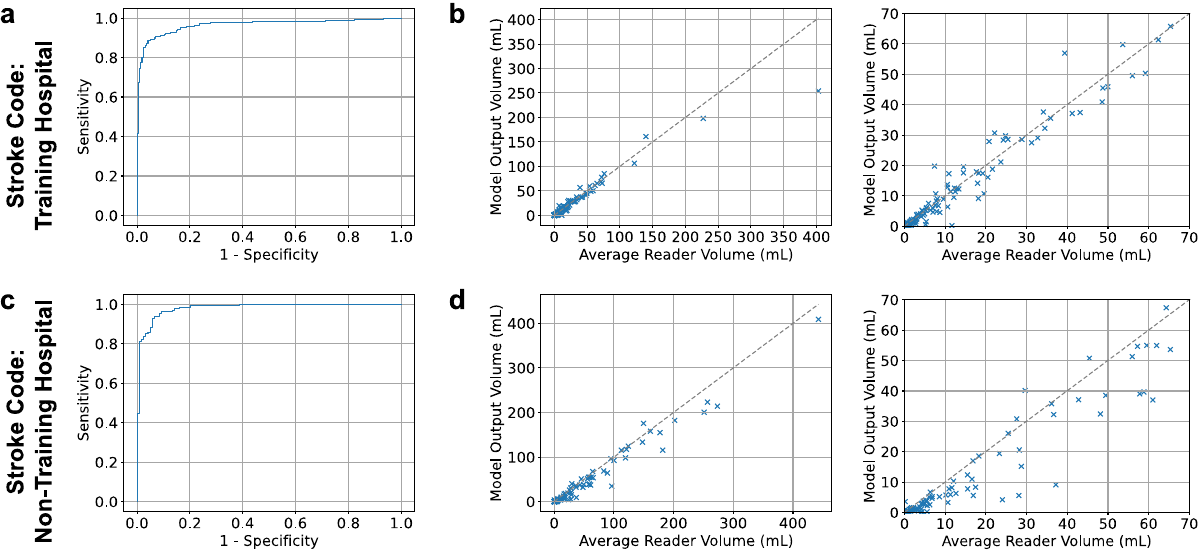
Figure 3. Model performance on stroke code test sets: ( a , b ) Training hospital stroke code receiver operating characteristic curve ( a ) and volume plot comparing averaged reader volume with model output volume ( b ; with magnified view of 0–70 mL on the right). ( c , d ) Non-training hospital stroke code receiver operating characteristic curve ( c ) and volume plot comparing averaged reader volume with model output volume ( d ; with magnified view of 0–70 mL on the